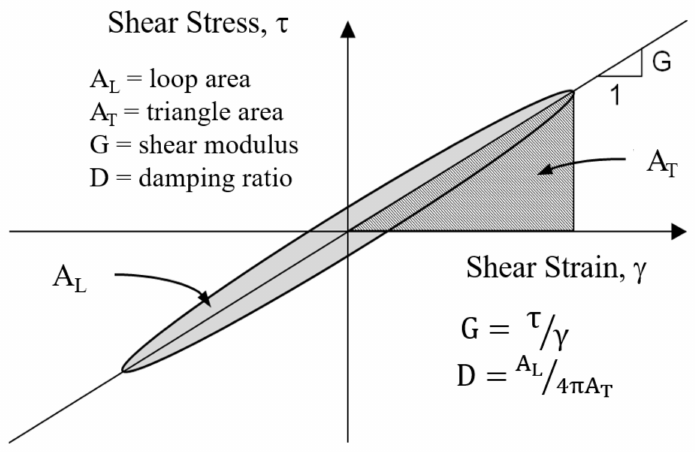
Figure 1. Damping ratio calculation from a stress–strain loop in torsional shear testing